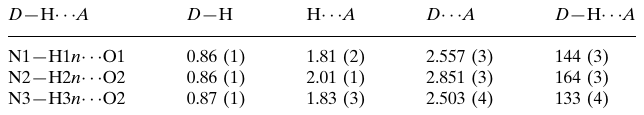
Hydrogen-bond geometry (A˚ , (cid:2)